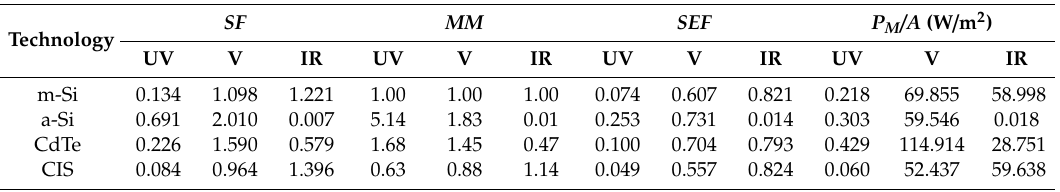
UV, visible, and IR